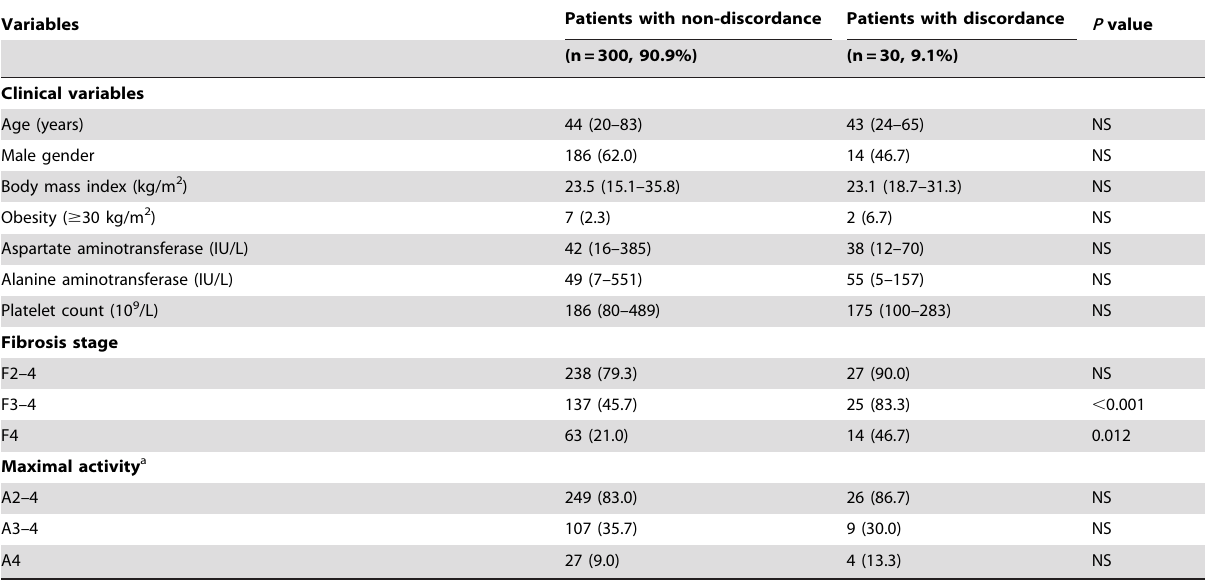
Table 4. Comparison of patients with non-discordance and those with discordance.